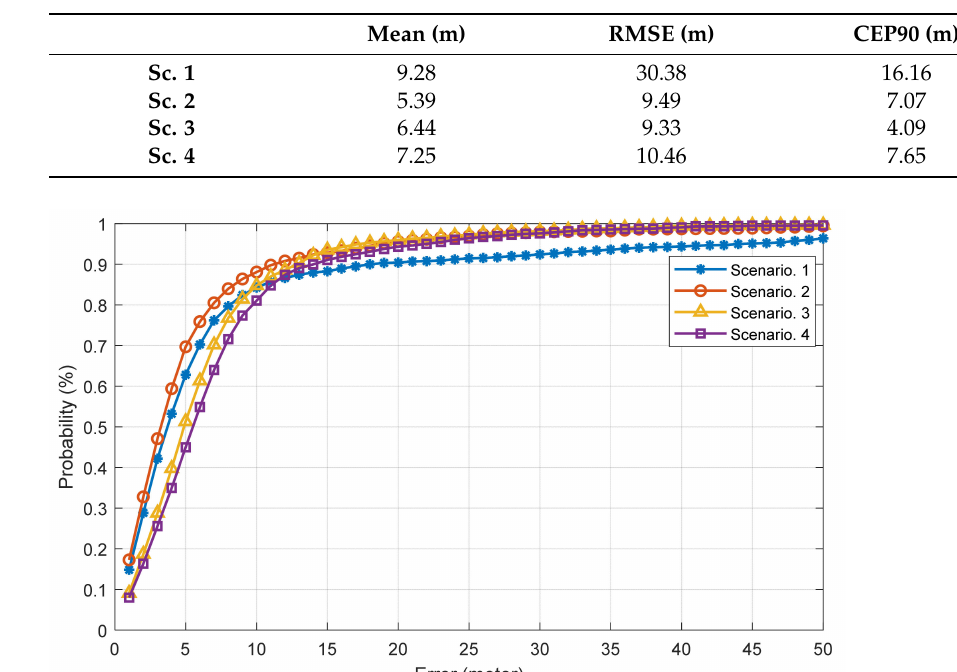
Figure 15. Positioning result of the fourth scenario in the entire test bed. Table 2. Analysis of positioning error of the proposed system (Scenario 1~4).